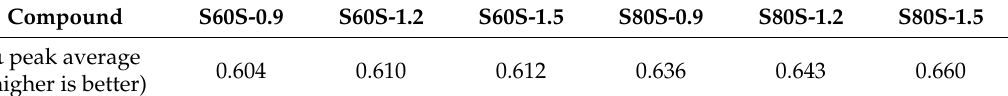
Table 8. Peak values of friction coefficient μ for vulcanizates from the rotational traction measuring system.